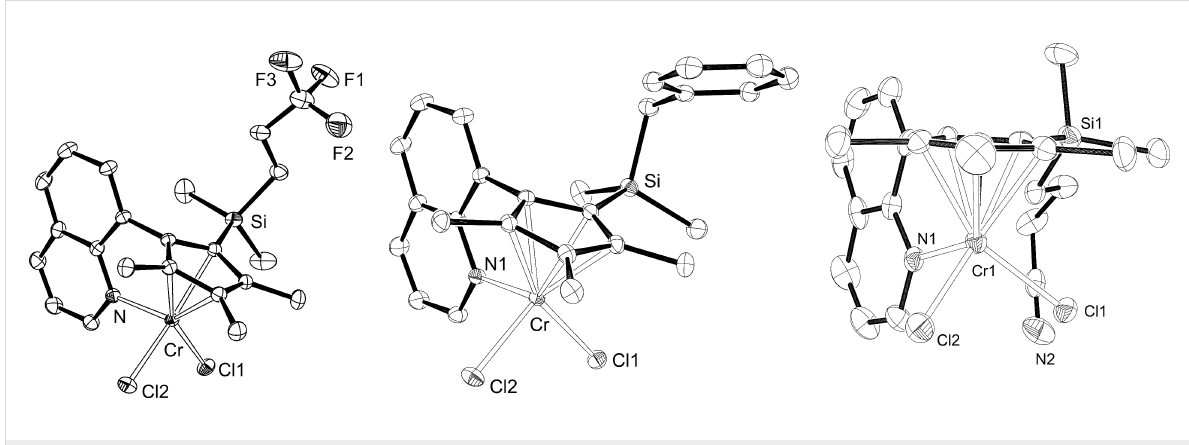
Figure 1: Solid-state molecular structures of selected complexes 4 , 7 and 8 (left, middle and right, respectively). Probability level: 50%. Hydrogen atoms and carbon labels are omitted for clarity.